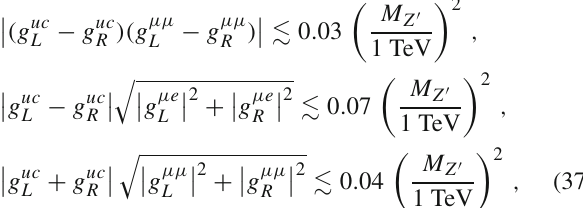
Fig. 9 The differential branching ratio of D + → π + e ± μ ∓ (plot to the left) and D + s → K + e ± μ ∓ (plot to the right) decays in mod- els with leptoquarks S 1 , 2 , | K (cid:3) parity violating SUSY benchmarks, K 9 = − K 10 = 0 . 009 (brown) and K 9 = − K 10 = 0 . 001 (magenta), and in Z (cid:3) -model solution 2,